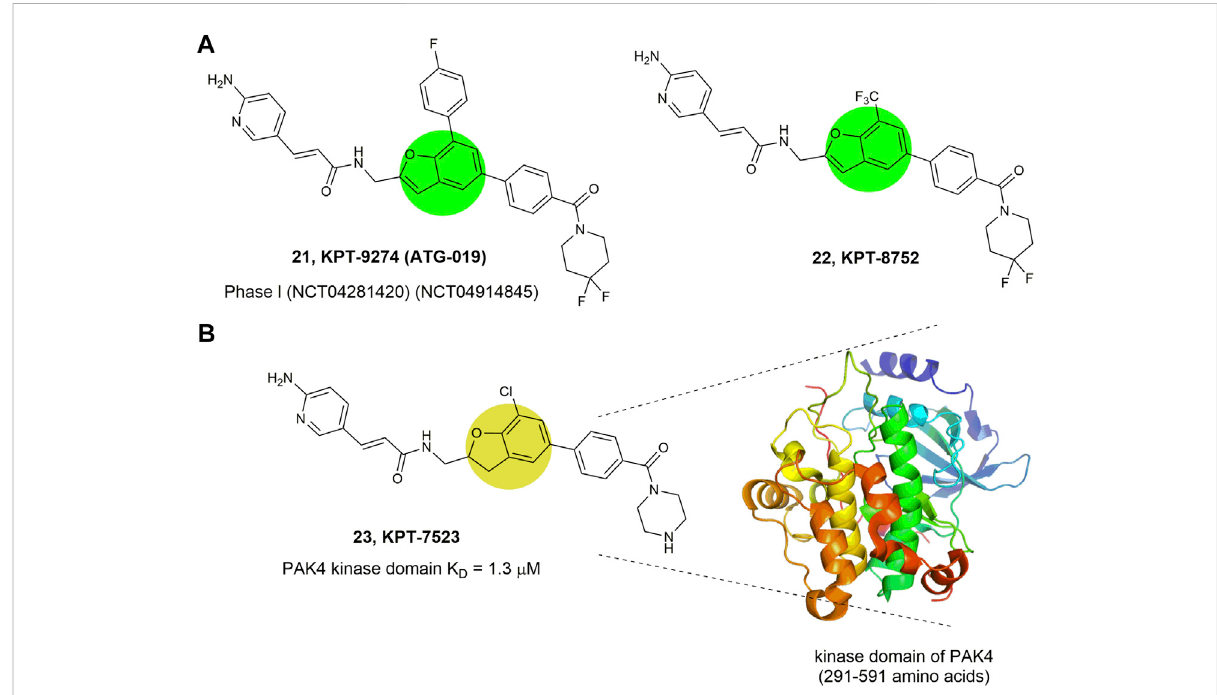
FIGURE 10 Structure of PAK4 allosteric inhibitors. (A) 21 and 22 bearing a benzofuran core. (B) 23 bearing a 2,3-diphydrobenzofuran core and its binding mode with the kinase domain of PAK4. The activity (IC 50 ) of these inhibitors against PAK4 kinase domain was not